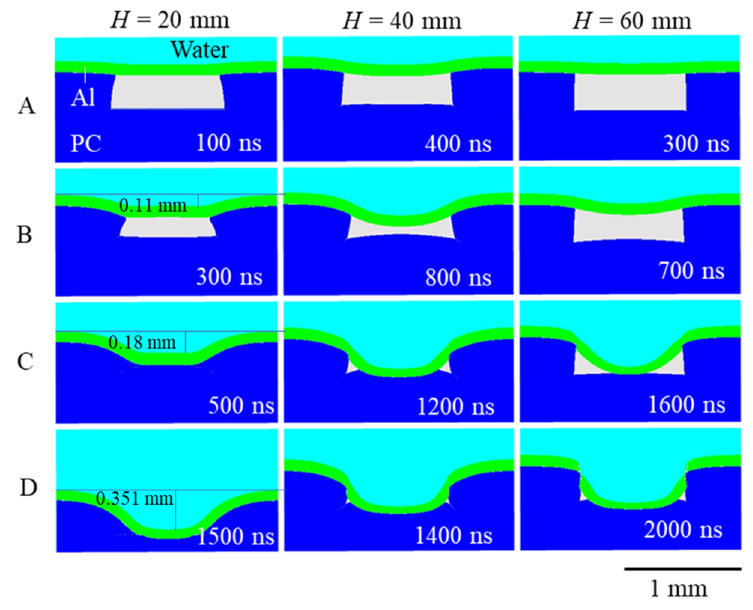
Figure 6. Deformation of the workpiece and mold due to the underwater shock wave. The strain rates of the workpiece and mold at specific times for each condition are shown in Figure 7. Specific time refers to the time when the maximum strain rate was output. The contours in Figure 7 show 10 7 and 10 6 /s for H = 20 mm and other conditions, respectively. This indicates the strain-rate region, where the dislocation avalanche can occur in the work piece. In the LSI studies using Si nanomolds, the workpiece deformation is constrained to the edges of the mold at strain rates >10 5 /s, resulting in a high dislocation density and dislocation avalanches in the workpiece (large deformation) [5,11,24]. On the